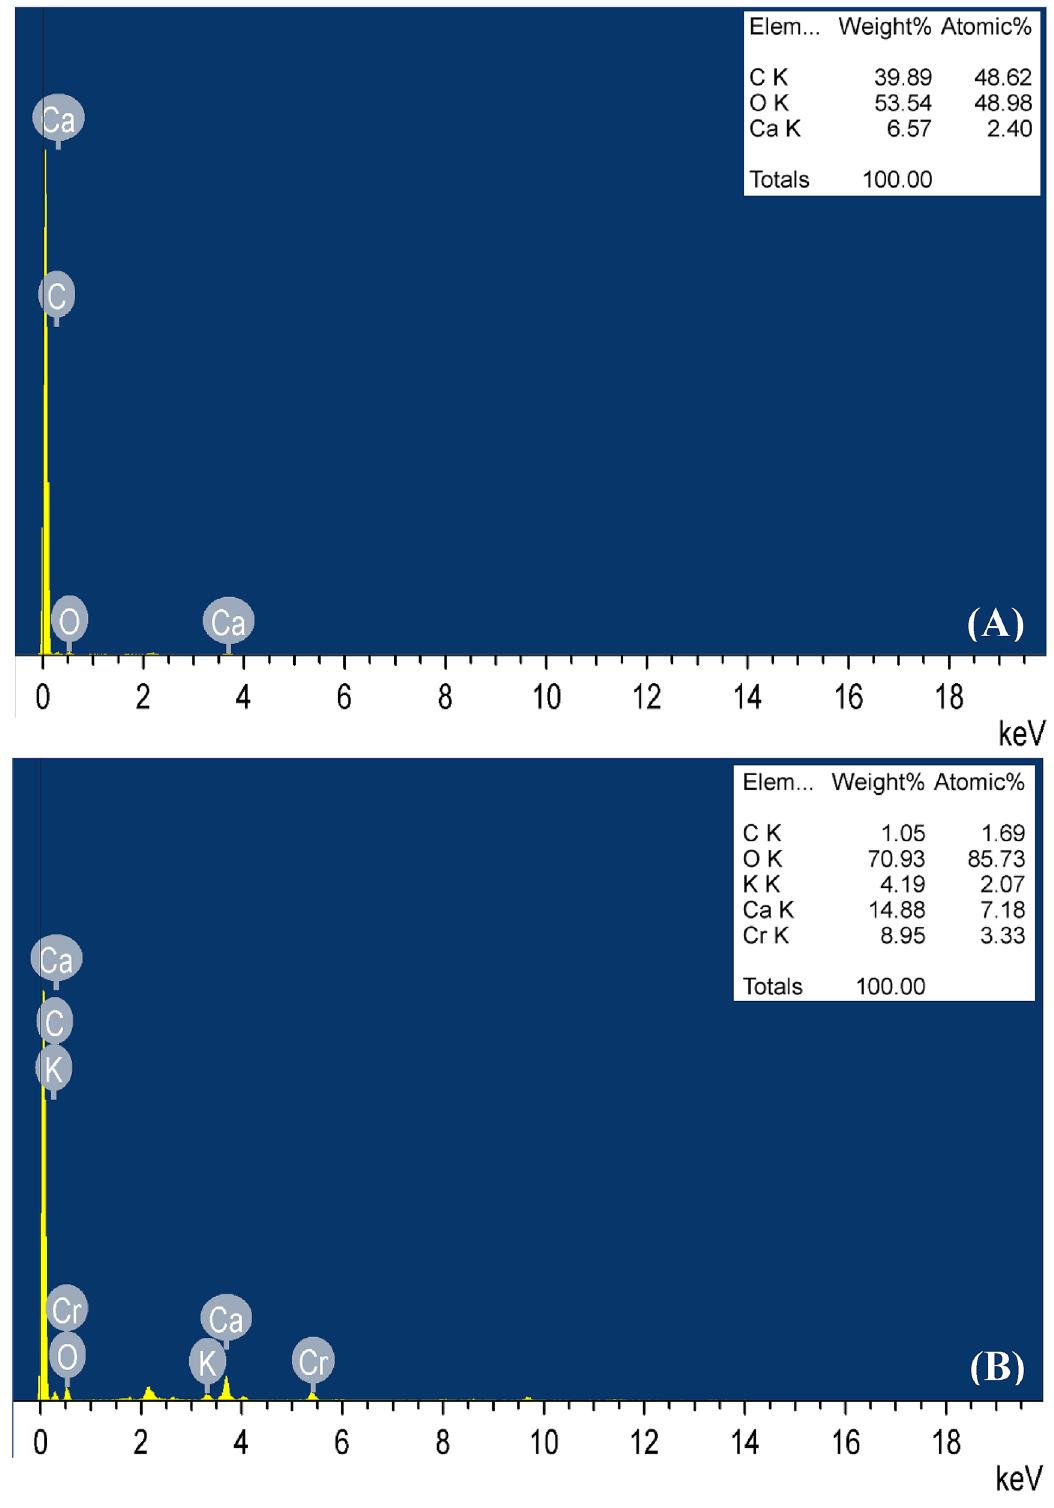
Figure 5. EDX analysis of the immobilized P. alcaliphila NEWG-2: ( A ) before and ( B ) after biosorption of Cr 6+